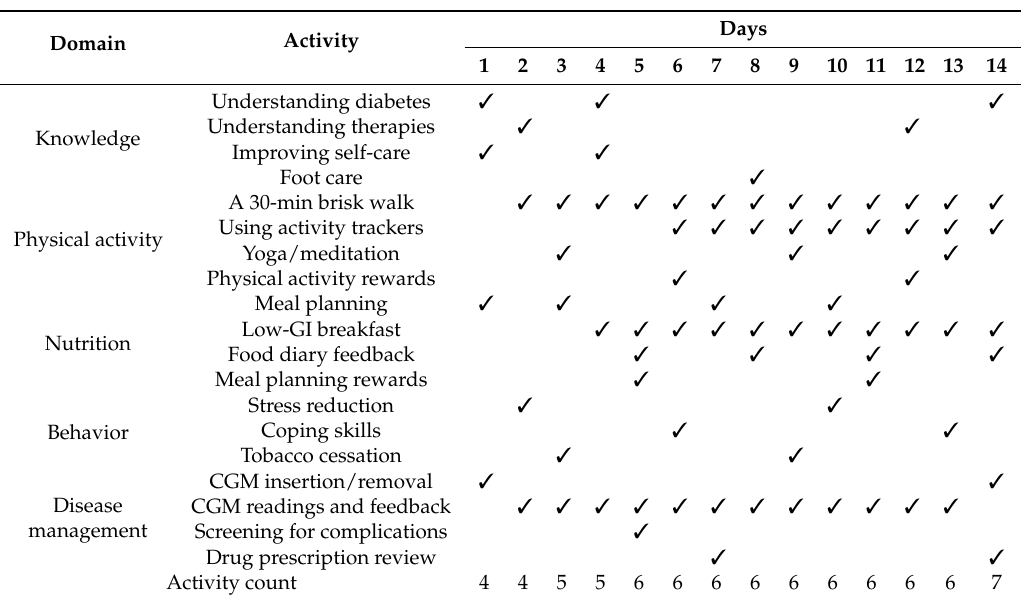
Table 2. Domains and underlying activity under diabetes self-management educational (DSME)